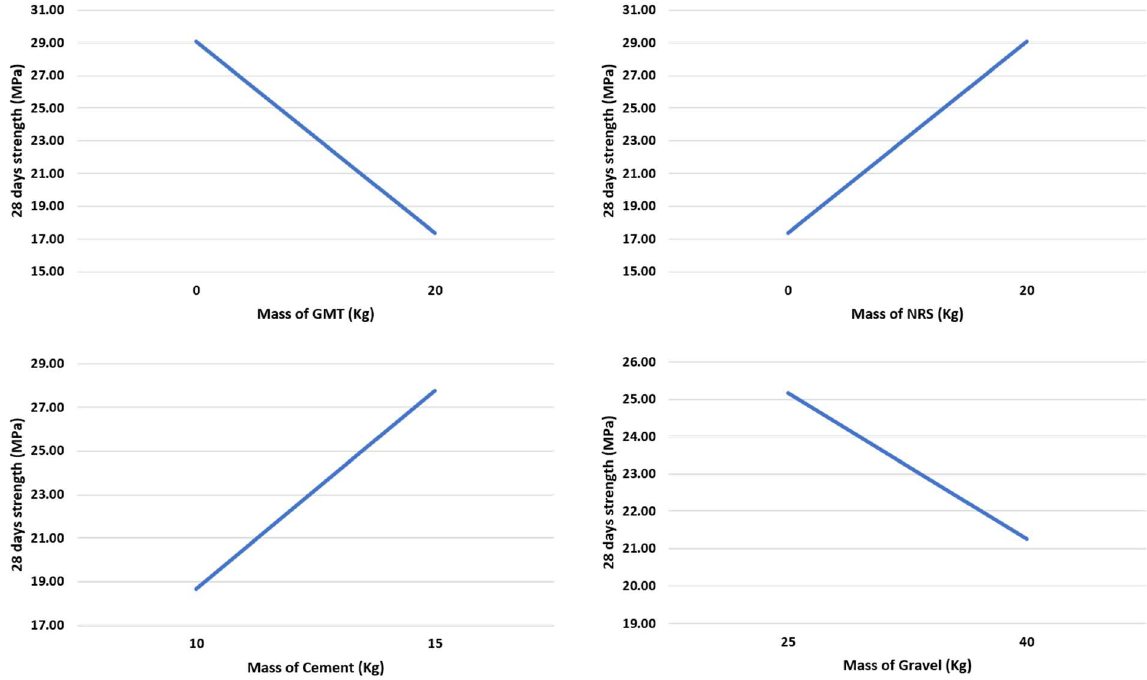
Figure 3. Influence of each concrete component individually on its compressive strength according to the DOE.